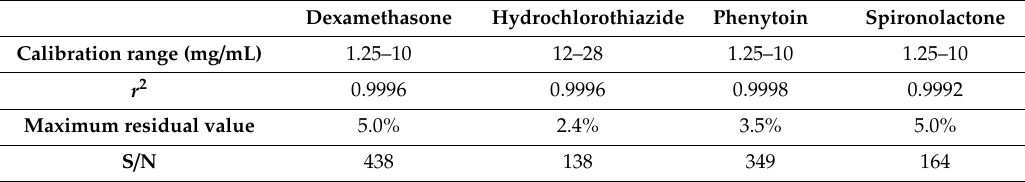
Table 2. Performance parameters obtained during linearity assessment of the di ff erent analytical methods developed to perform dexamethasone, hydrochlorothiazide, phenytoin, or spironolactone assay.